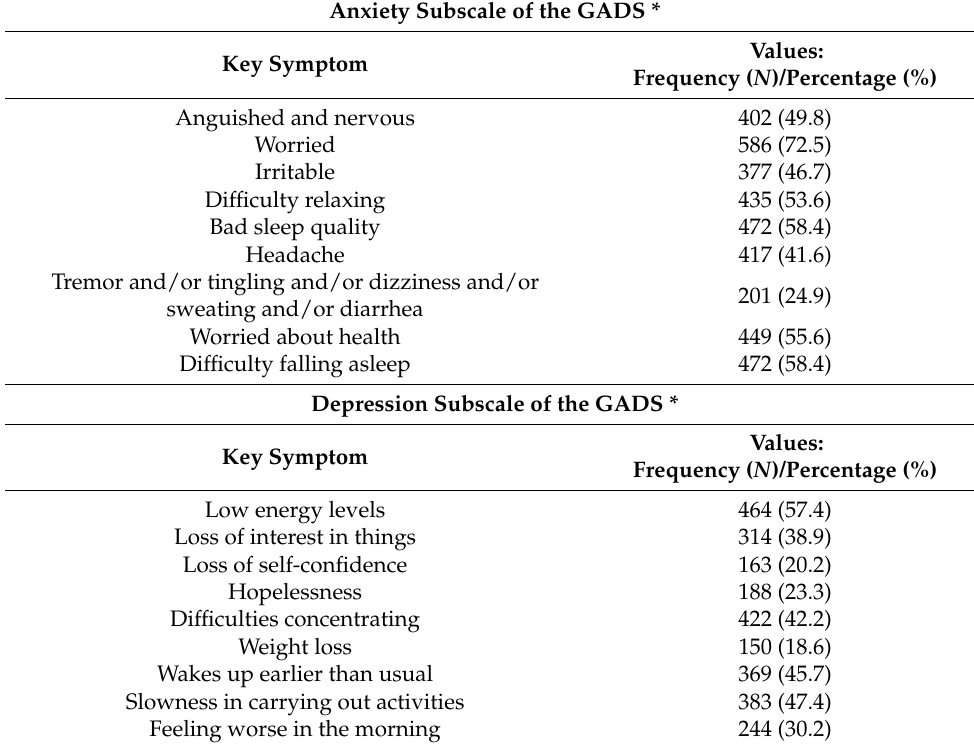
Table 2. Affirmative responses in anxiety and depression subscales of the GADS * ( † N = 808), Spain, 2020.